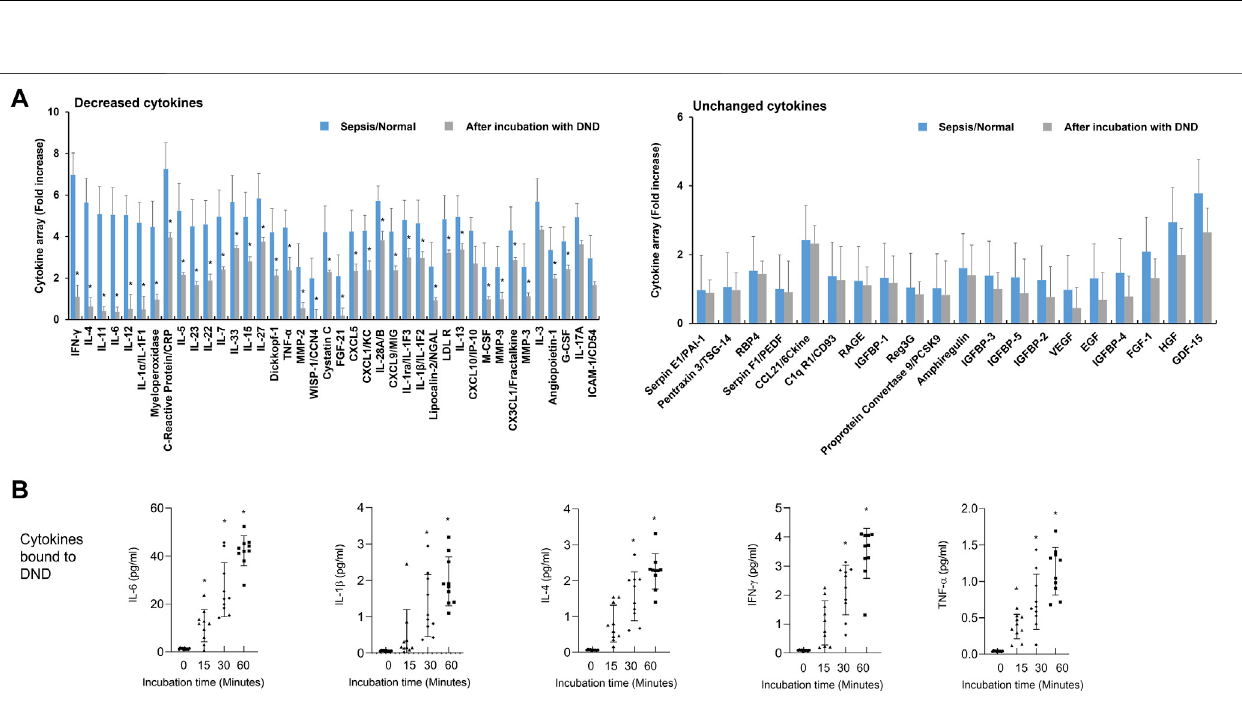
FIGURE4| Highlypuri fi edDNDamelioratescytokinelevelsintheplasmaofpneumoniapatients( n =10). (A) Cytokinearrayshowingwhichin fl ammatorymediators areadsorbed(leftgraph)ornot(rightgraph)totheDNDfromtheproteomeanalysis. (B) TheadsorptionkineticsofDNDwithkeycytokinesincludingIL-6,IL-1 β ,IL-4,IFN- γ , and TNF- α in the plasma of patients with pneumonia ( n = 10). Data are mean ± SEM with signi fi cance set at * p < 0.05 compared to the control group.